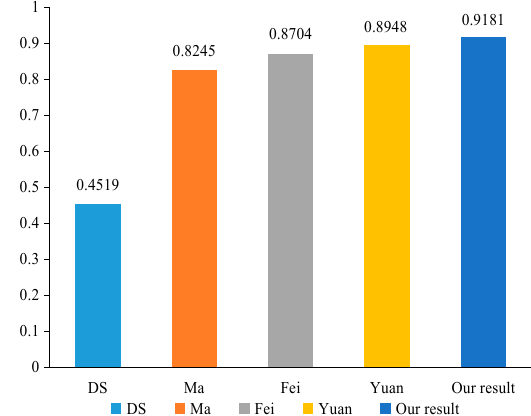
Figure 8. The comparison of the belief value for fault type F 1 in different methods.